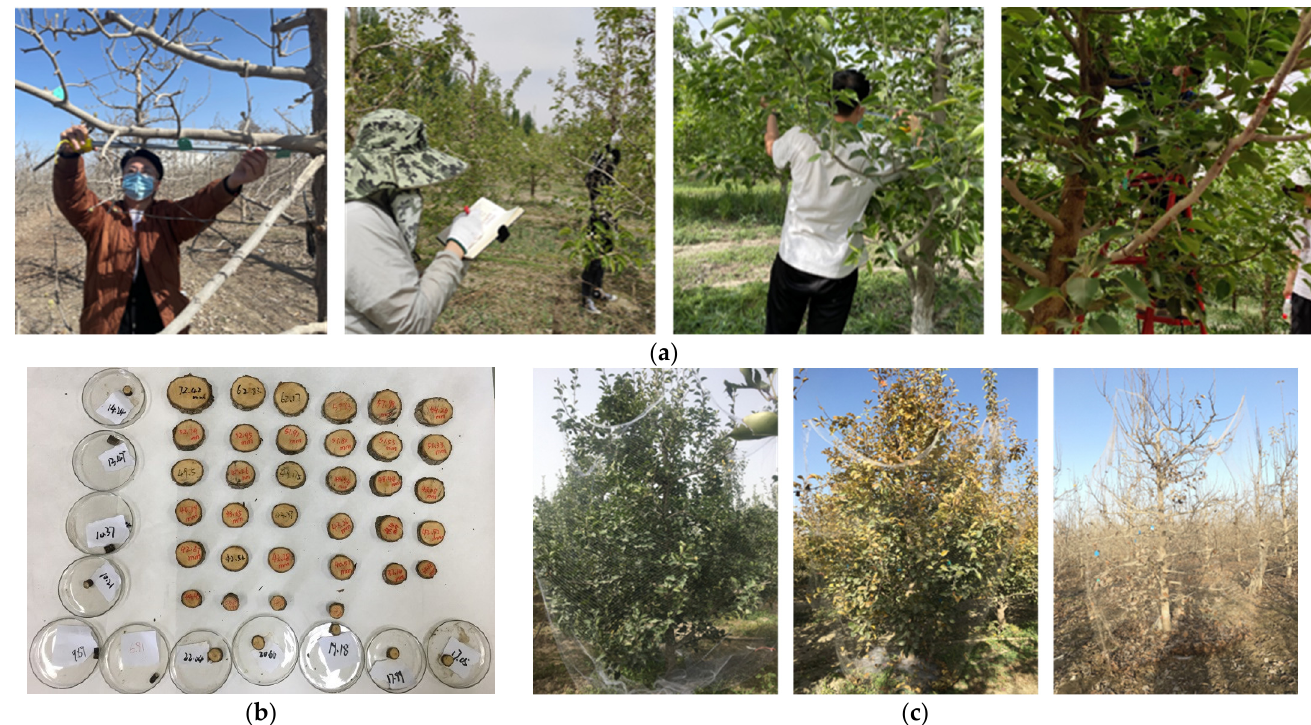
Figure 4. ( a ) Field data acquisition such as biomass collection, phenological observations and pruning measurements; ( b ) measurement of stems of different diameters; ( c ) collecting all fallen leaves after harvesting.